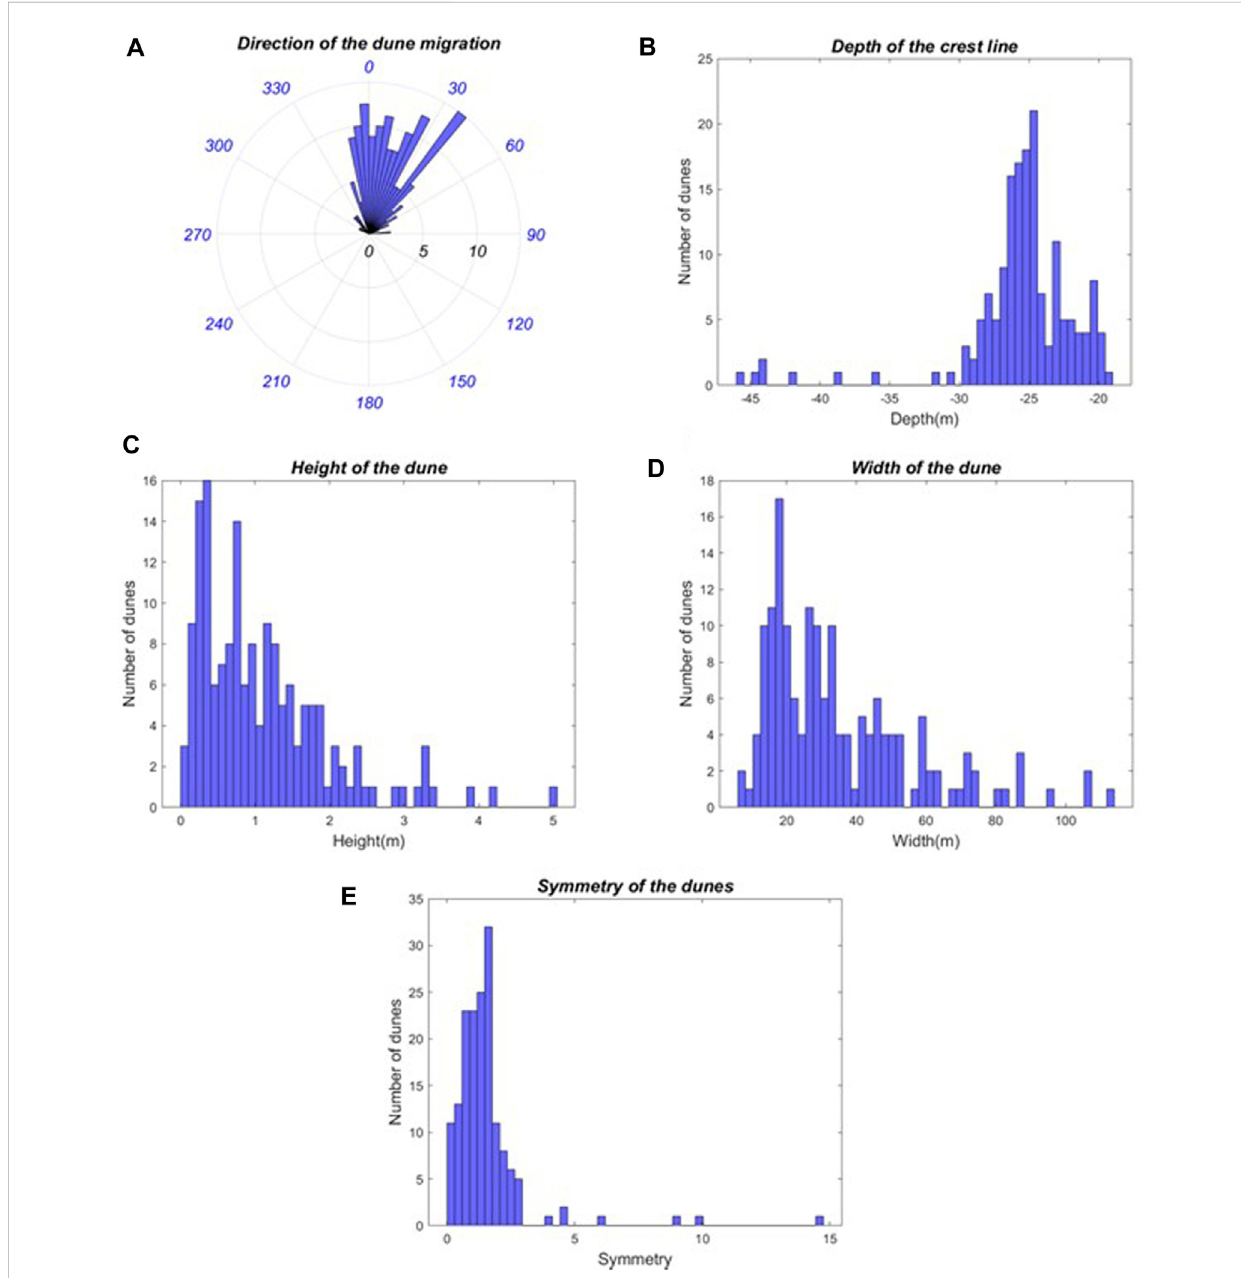
FIGURE 13 Histograms of morphological descriptors values [cf. (A – E)